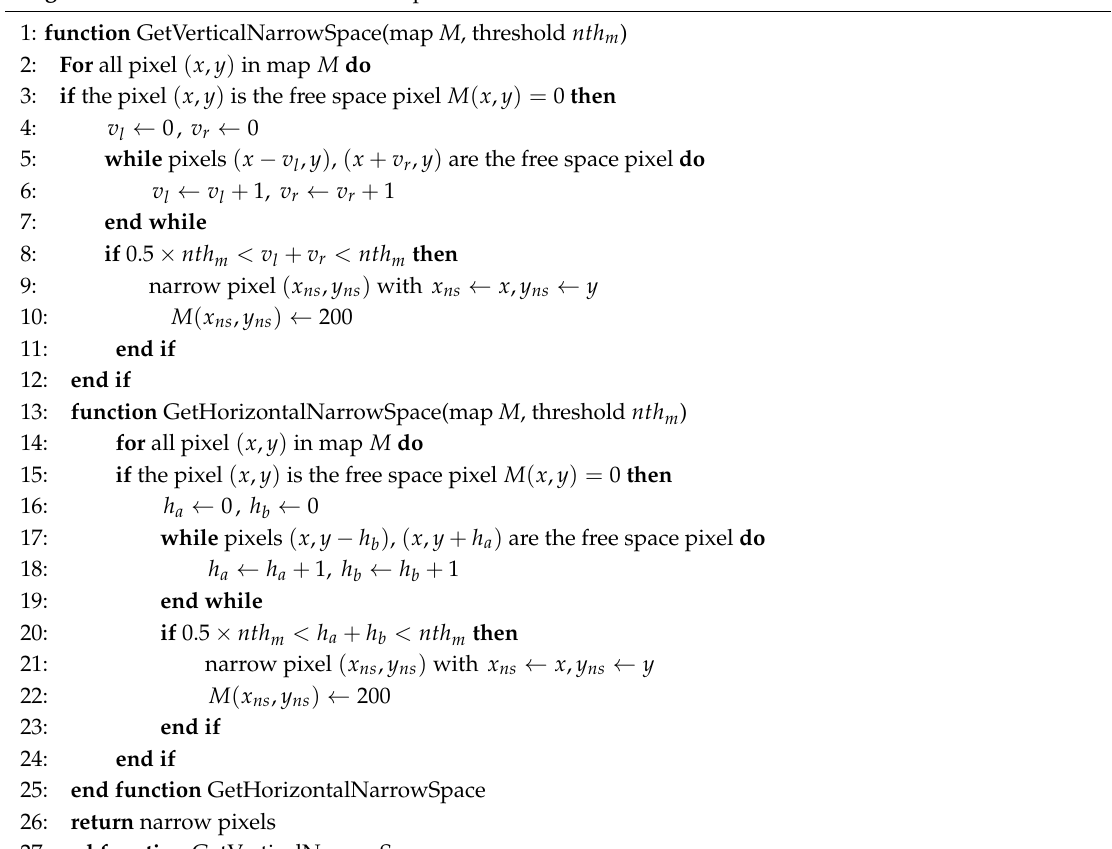
Figure 13. Narrow space pixels estimation. ( a ) Defining horizontal vertical narrow pixel, ( b ) defining horizontal narrow pixel. Algorithm 3 Determination of narrow space areas